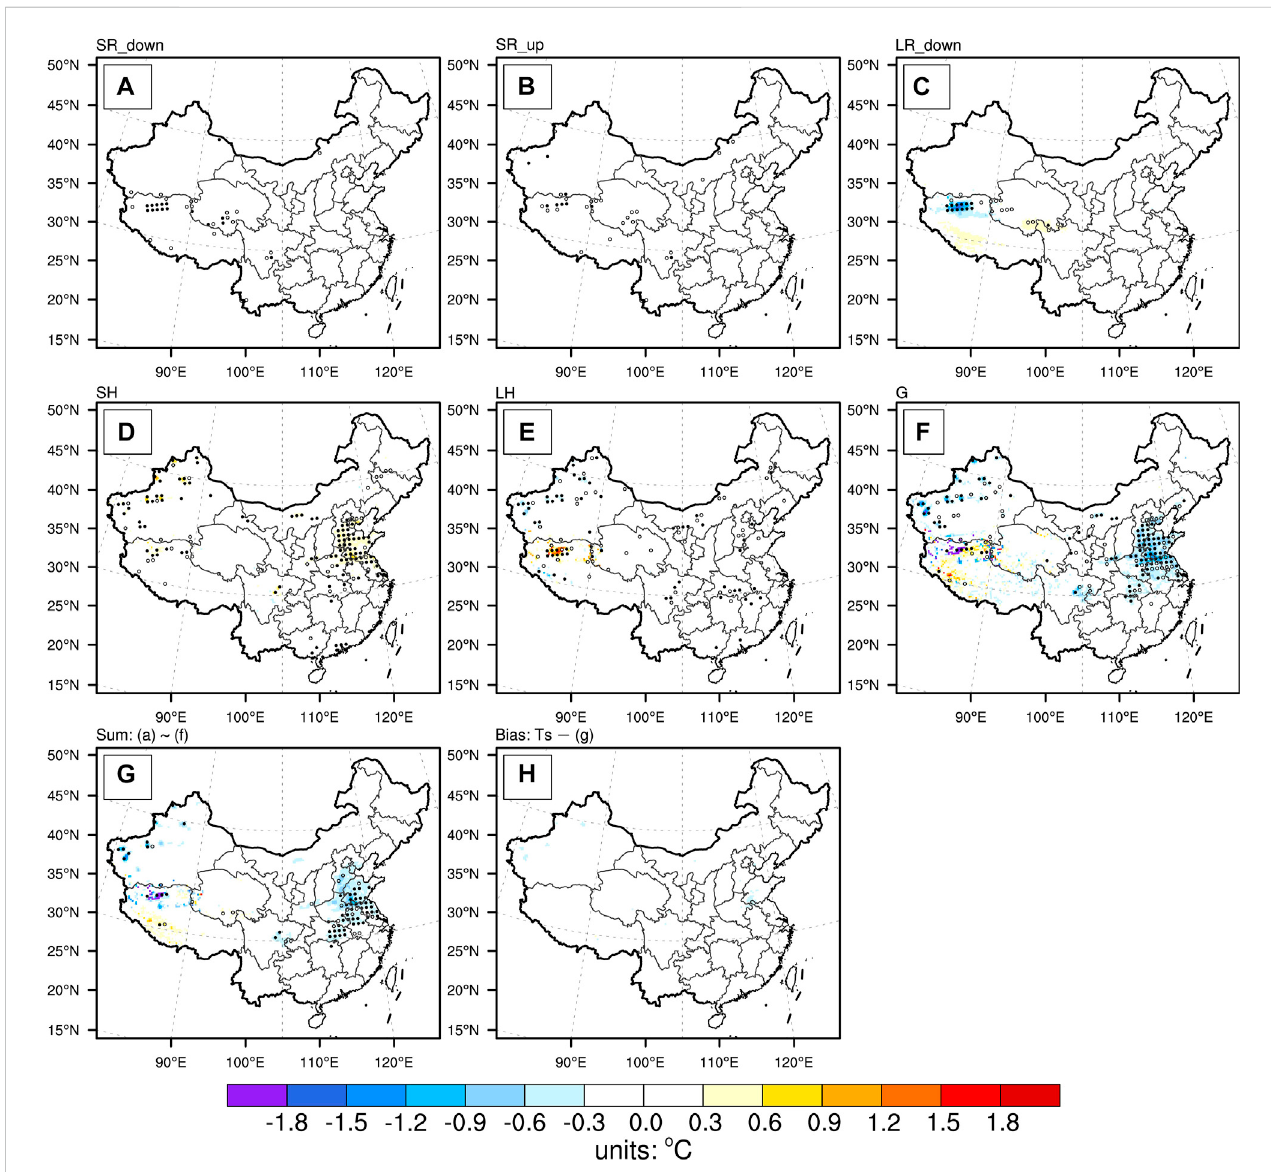
FIGURE 8 Ensemble mean results of the irrigation-induced multiyear mean changes in nighttime (18 UTC) surface temperature due to changes in the surface energy budget components: (A) downward shortwave radiation, (B) upward shortwave radiation, (C) downward longwave radiation, (D) sensible heat fl ux, (E) latent heat fl ux, (F) ground heat fl ux, (G) sum of (A – F) and (H) errors of the decomposed temperature metric [i.e., simulated land surface temperature minus (G) ], units: ° C. The meanings of solid and hollow dots are the same as Figure